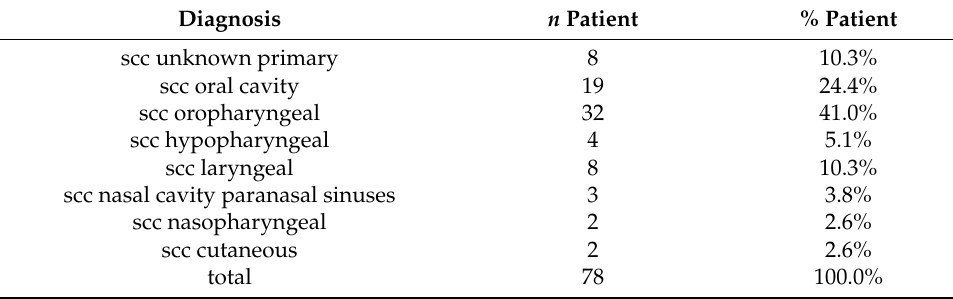
Table 1. Diagnosis, number and percentage of